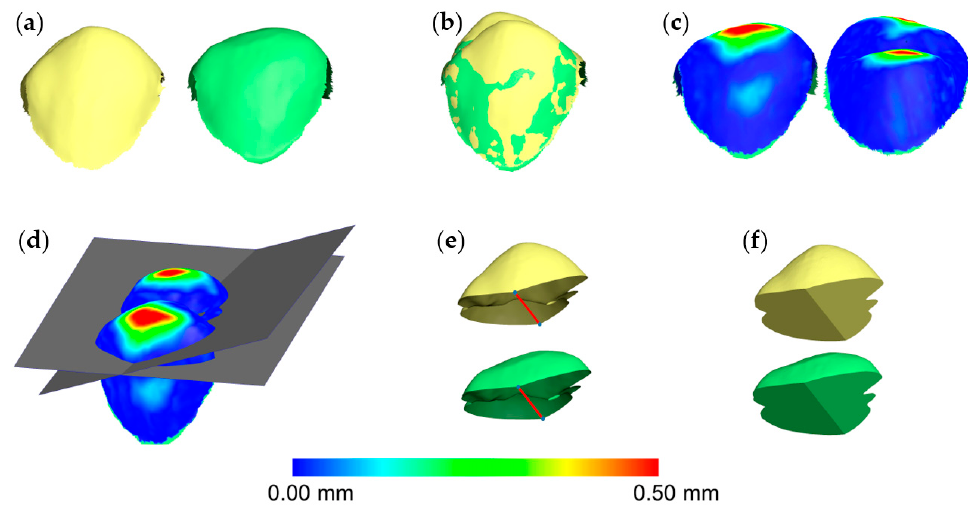
Figure 3. Workflow of tooth wear assessment in a maxillary first premolar. ( a ) Tooth crown before (yellow) and after (green) wear simulation. ( b ) Tooth crowns superimposed through the complete crown technique with setting D (30% estimated overlap). ( c ) Color coded distance map showing the tooth wear from the buccal (left) and the lingual (right) side. ( d ) Two levels (grey) used to simulta- neously slice the two crowns. ( e ) Sliced tooth crowns with connected contralateral points (blue) in sharp edges (red line), splitting the hole in two parts to ensure identical hole-filling process. ( f ) Holes filled to create watertight models and, thus, calculate volumes.